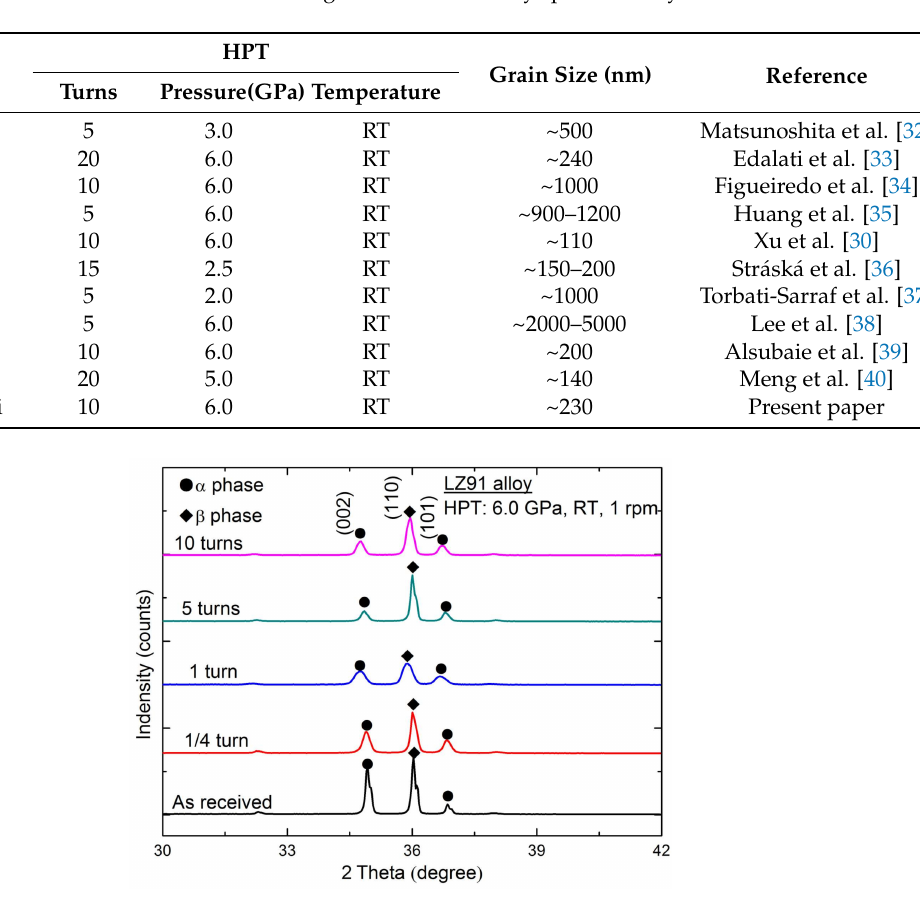
Table 2. Grain sizes of magnesium and its alloys processed by HPT.